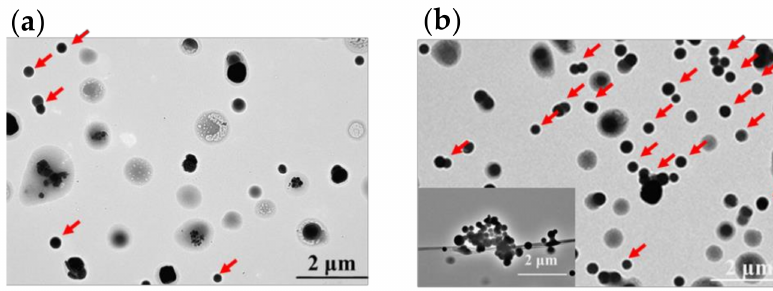
Figure 4. TEM images of ( a ) no. 1 and ( b ) no. 3. The red arrows denote TBs.